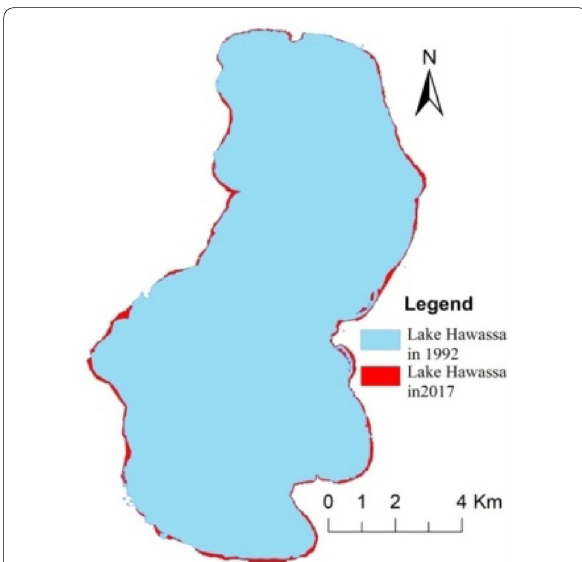
Fig. 8 Surface area of the Lake Hawassa in 1992 and 2017